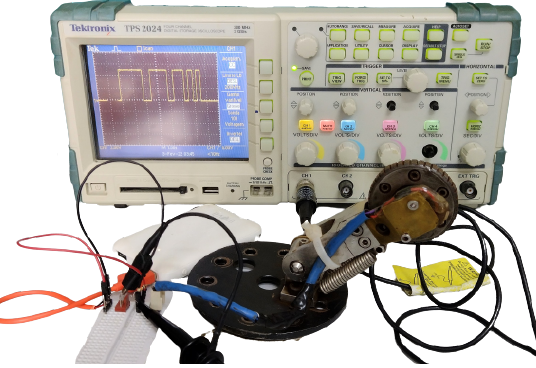
Figure 29. Experimental setup that illustrates the Hall-effect switch’s output.